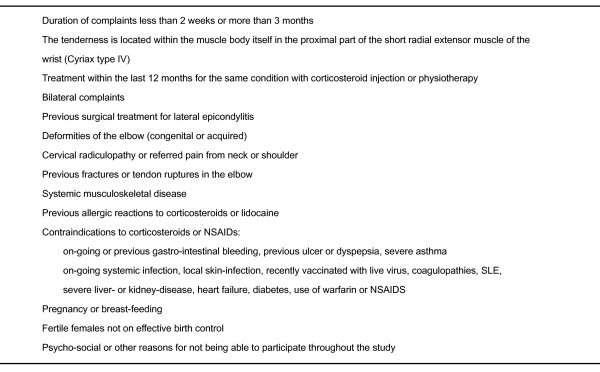
Exclusion criteria.